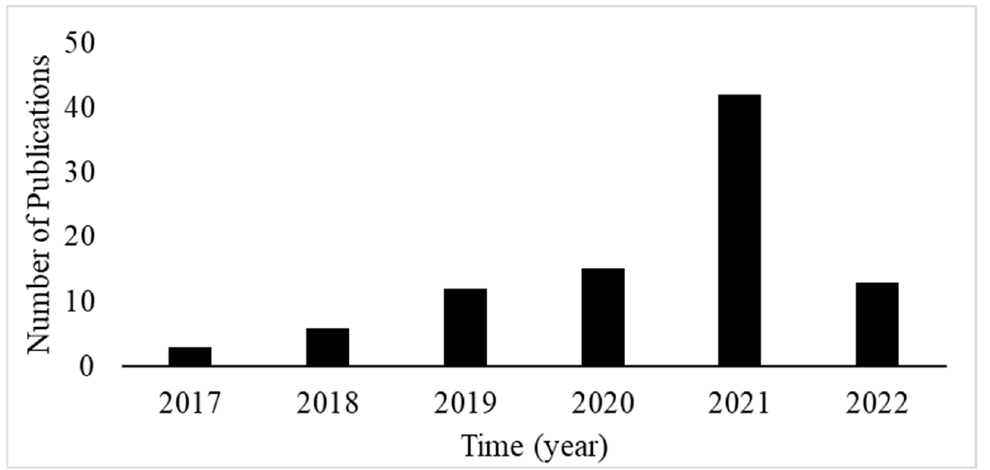
Figure 2. The number of annual publications on the deep ‐ learning ‐ based point cloud registration from years 2017–2022 based on our screening statistics.